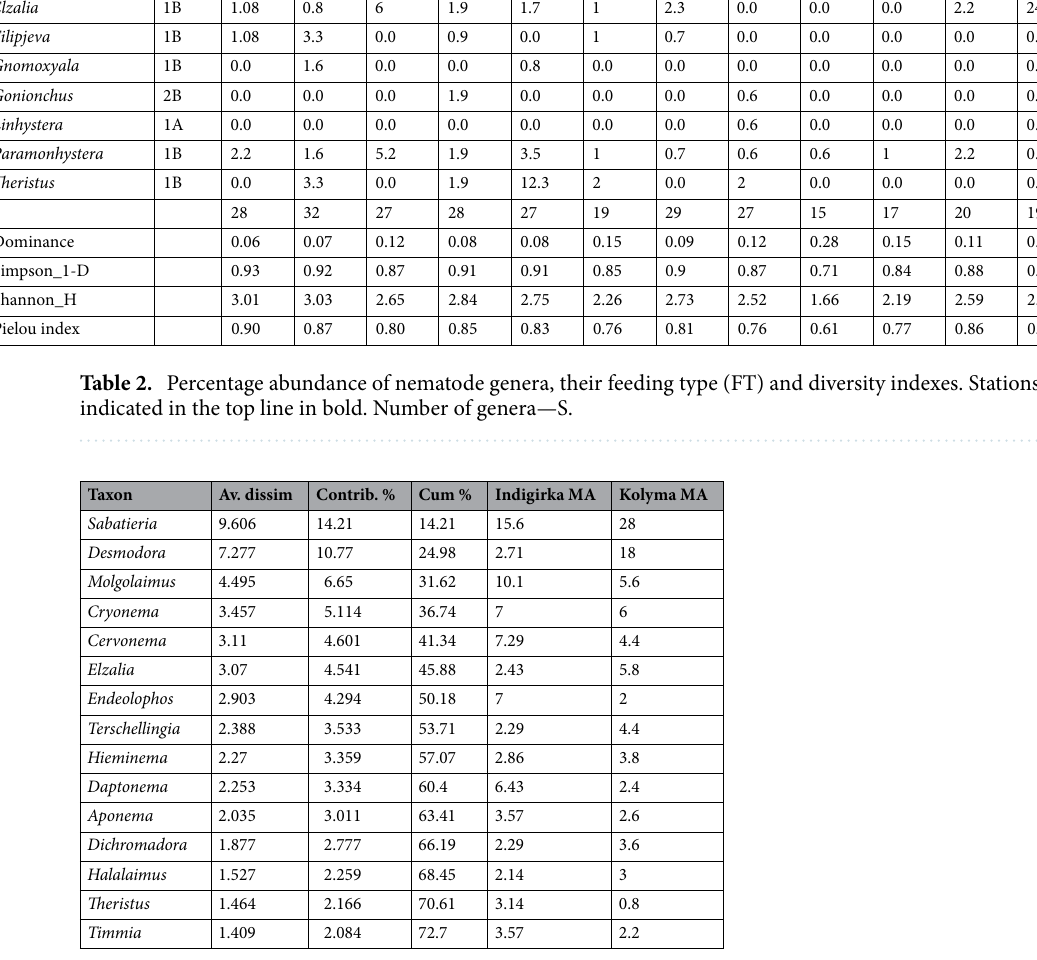
Table 3. Fifteen most important nematodes genera in the ESS. Av. dissim.—overall average dissimilarity; Contrib.—contribution (%); Cum—cumulative (%); MA—mean abundance in each of the two transects. Indigirka—Indigirka transect, Kolyma—Kolyma